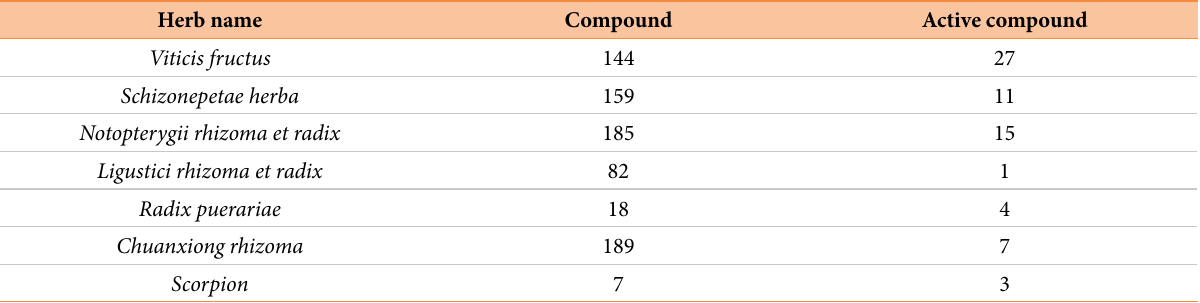
Table 2 - The compositions of Lutongkeli prescription.